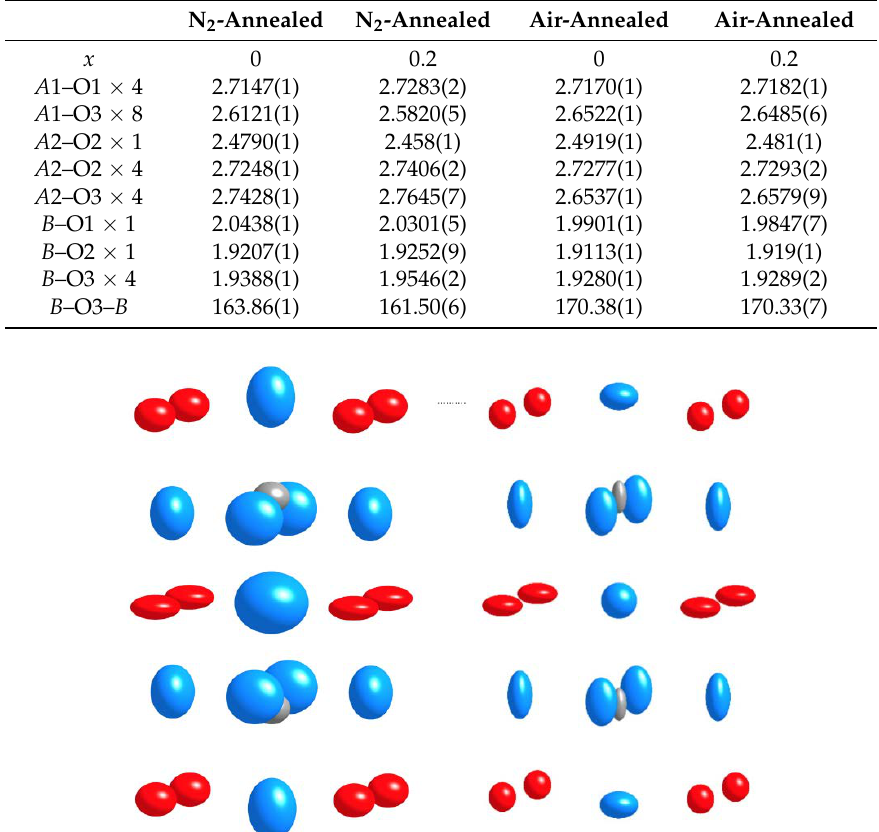
same. This is in agreement with the Sr/Pr content from the NPD and XRD refinements (see below),